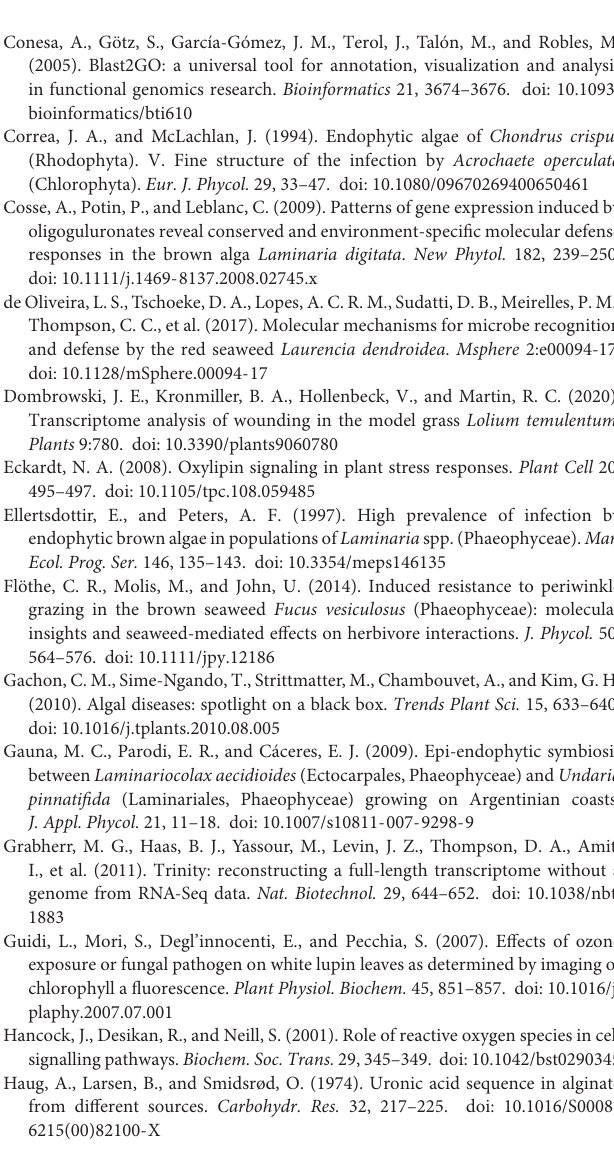
Supplementary Figure 2 | Distribution of the functional categories derived from Gene Ontology terms obtained by Blast2GO hits of genes from the S. latissima and the L. digitata transcriptome. Supplementary Figure 3 | Expression levels of unigenes in triplicate samples from (A) S. latissima and (B) L. digitata after 24 and 48 h of culture without (Control: C1–3) or with L. elsbetiae (Endophyte co-culture: E1–3). Supplementary Table 1 | Statistical analysis of growth and Fv/Fm measurements during the co-cultivation bioassay with the two kelp species. Supplementary Table 2 | Statistical analysis of growth measurement between the co-cultivation bioassay and GG pre-treatment using L. digitata . Supplementary Table 3 | Summary of the Trinity assembly and annotation for S. latissima and L. digitata